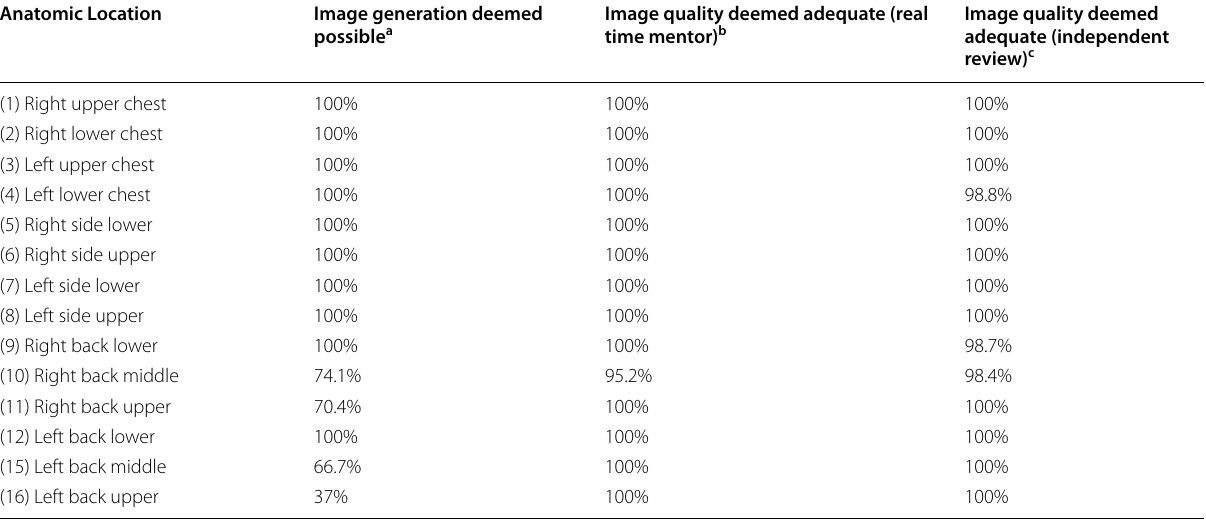
Anatomic location is visually demonstrated in Fig. 1 a Image Generation was the remote mentoring expert’s assessment of the interaction with the participant as to whether assessing the anatomic location was possible to image b Image Quality was assessed real time by the Mentor during the examination c Image Quality was assessed as the composite result of the a-prior independent review of the images/videos